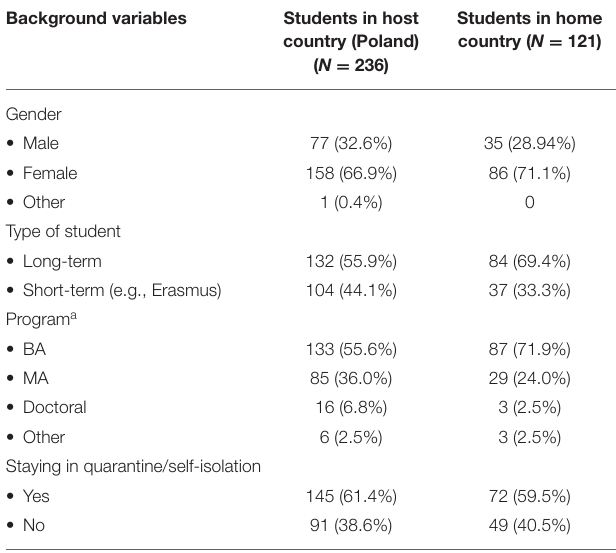
TABLE 1 | Participants’ characteristics ( N =